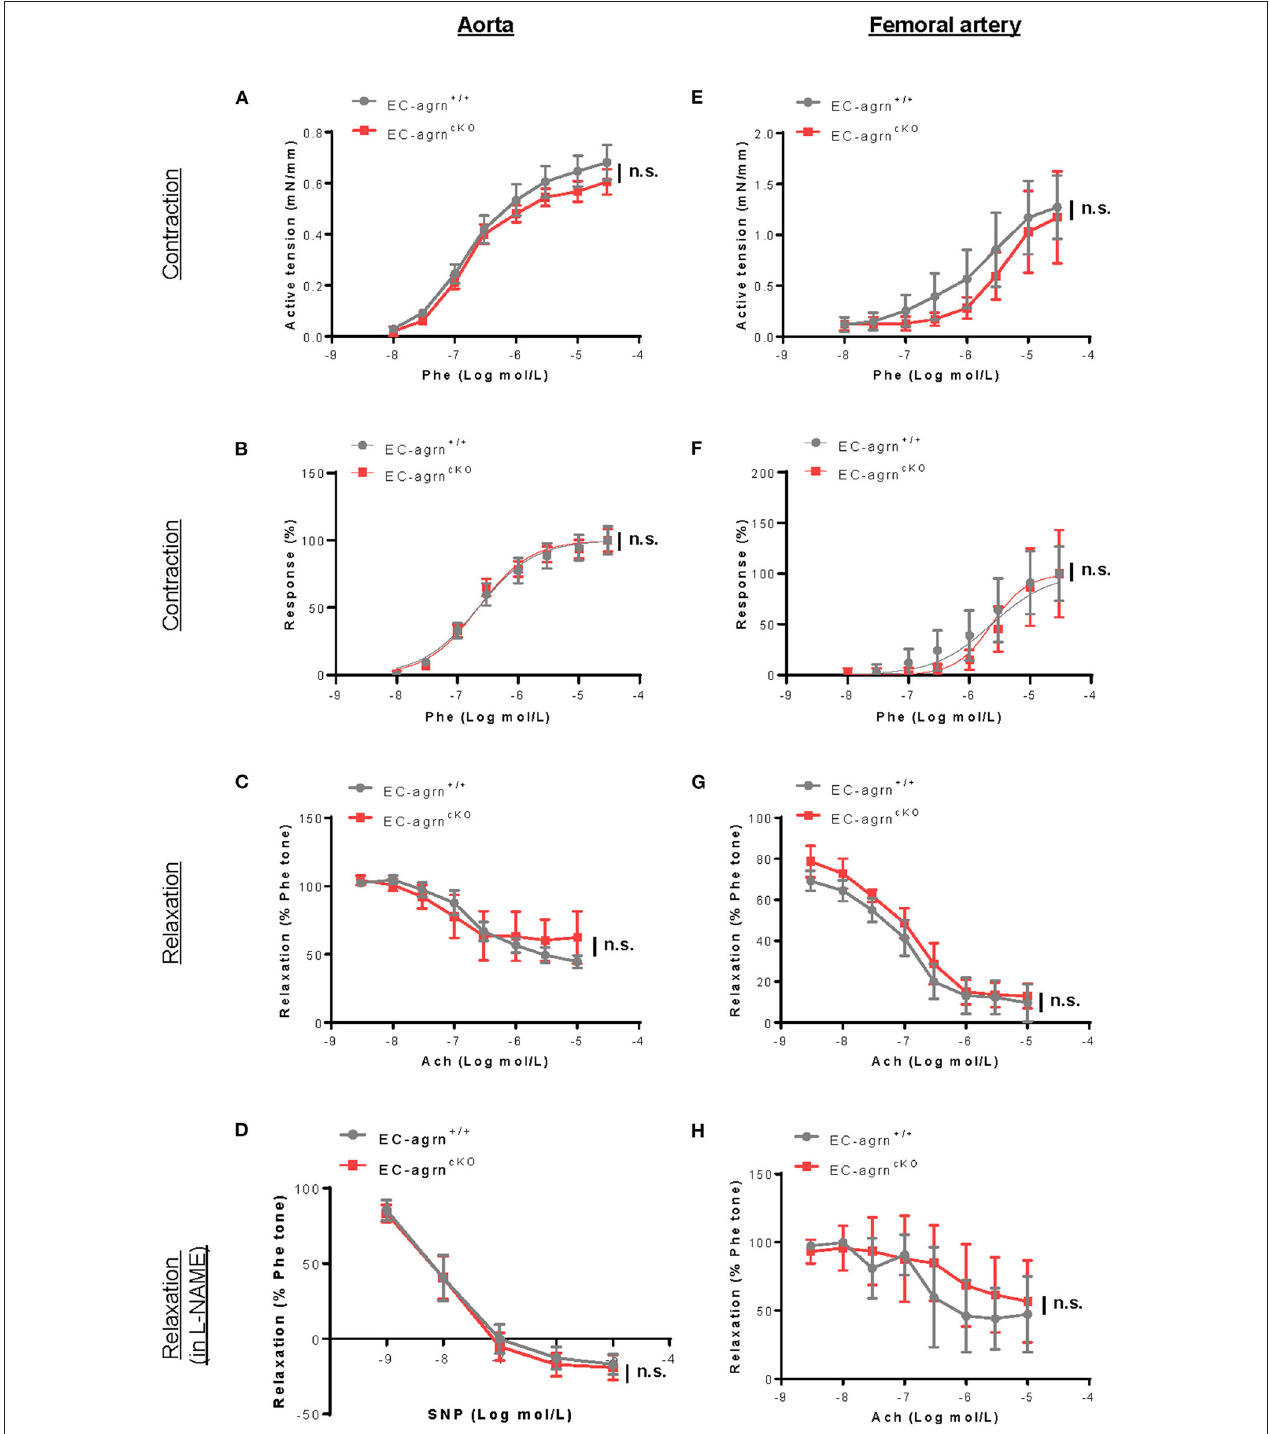
FIGURE 3 | Endothelial agrin is dispensable for endothelium dependent vasoreactivity in vivo . (A–F) Concentration dependent vasoreactivity measured in the (A–D) aorta and (E–H) femoral artery of 6-8 weeks old EC-agrn + / + and EC-agrn cKO mice, respectively, showing no significant difference after endothelial loss of agrin. (A,E) Concentration dependent vasocontractions of mouse aorta or femoral artery of the limb in response to phenylephrine (Phe) were measured. (B,F) Dose response curve showing EC50 of Phe-induced vasocontractions. (C,G) Concentration dependent EDRs of mouse aorta or femoral artery of the limb in response to acetylcholine (Ach) were measured. (D,H) Reactions were antagonized by co-treatment with NOS inhibitor, L-NAME. (A–H) Data are presented as mean ± S.E.M., n = 5–6, differences were determined by ANOVA and Turkey’s HSD post-hoc test, n.s. denotes no significant difference.